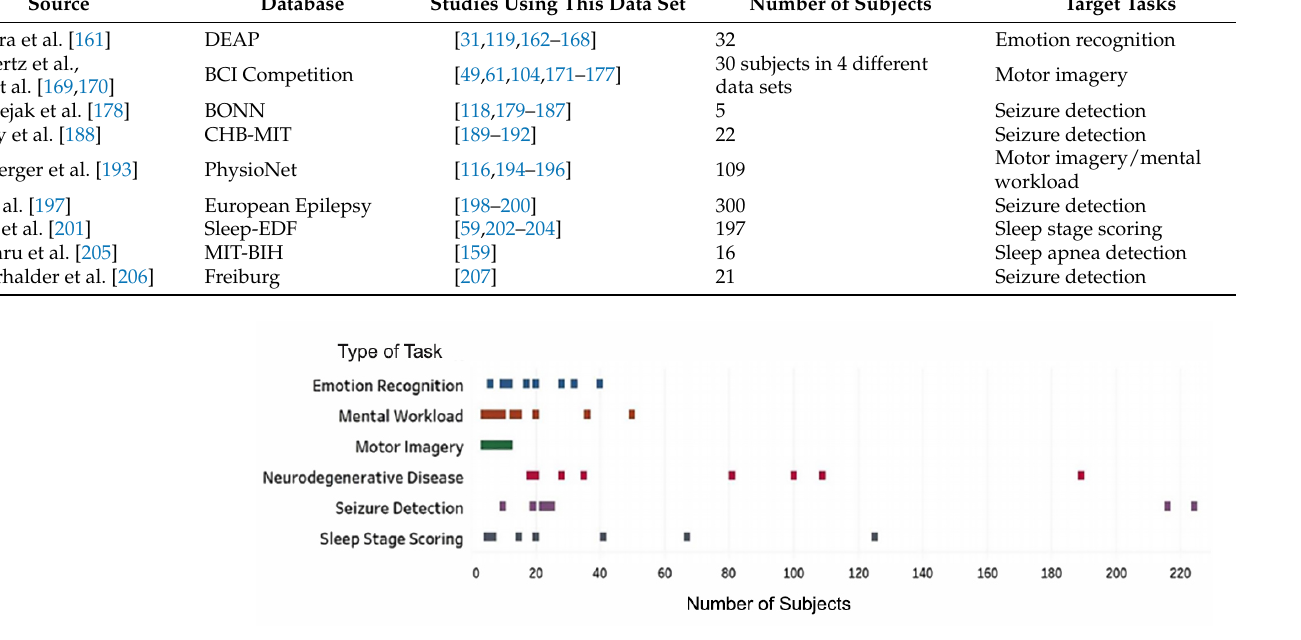
Figure 6. Number of subjects per task in each study